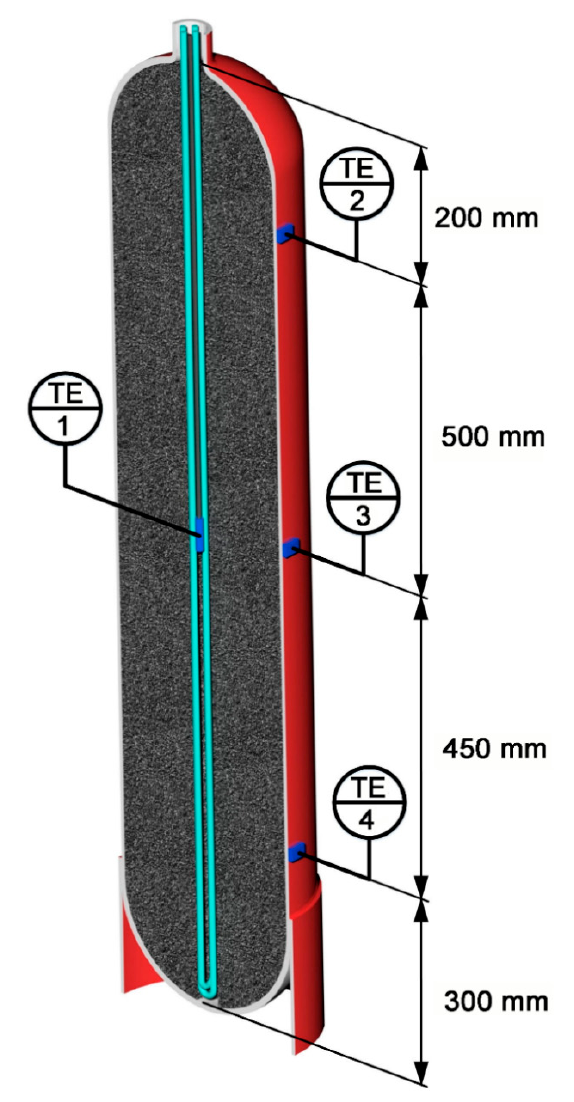
Figure 2. The longitudinal section of the ANG tank packed with carbon adsorbent and equipped with Table 1. The external heat-exchanger is not shown. The sensors are isolated from the heat exchangers and are located between the coil turns. Table 1. The parameters of the porous structure of the coconut shell (CNS)-derived AC adsorbents with the various burn-off degree, packing density, and globular sizes evaluated from adsorption data